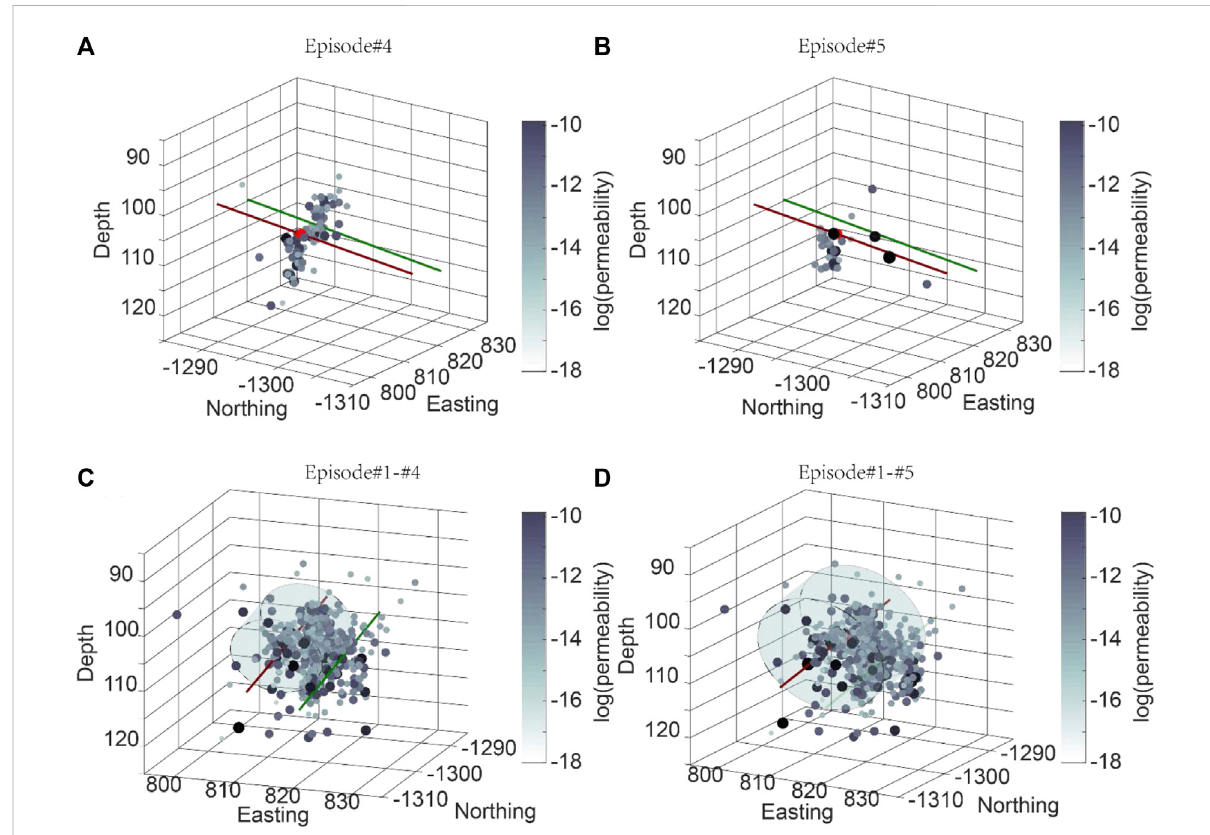
FIGURE 6 Spatial in situ permeability map. (A) and (B) show spatial permeability distribution for episodes #4 and #5 only. (C) and (D) show local fracture permeabilitycumulatedfromepisodes#1 – #4and#1 – #5.Theoutercontourofthecylindricalvolumefollowstheextentofwatermigrationwiththe colorindicatingaveragereservoirpermeabilitypredictedfromtheMLmodelattheendofepisodes#4and#5.Redandbluelinesrepresentinjection and production well, respectively.